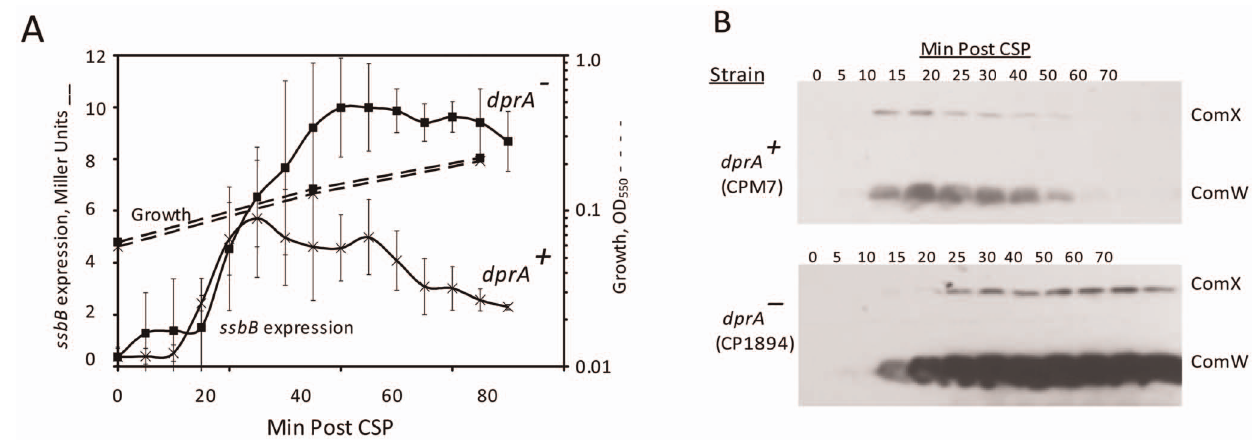
Figure 4. Prolonged appearance of ComX and ComW in a dprA mutant. A. Late gene expresion in strains CPM7 (x, dprA + ) and CP1894 ( % , D dprA ) was monitored by measuring b -galactosidase activity (Miller units) ( 2 ) in a culture treated with CSP, using a lacZ transcriptional fusion to the ssbB promoter. Points are averages of three samples and error bars represent their standard deviation. –, growth of parallel non-CSP treated cultures. B. Western analysis of samples taken in parallel to samples for late gene expression run in a separate gel, transferred to a separate membrane for each strain and probed with antisera specific to both ComX and ComW using the ECL substrate and imaged on a separate film for each strain. Each lane represents a cell lysate from 0.6 ml of